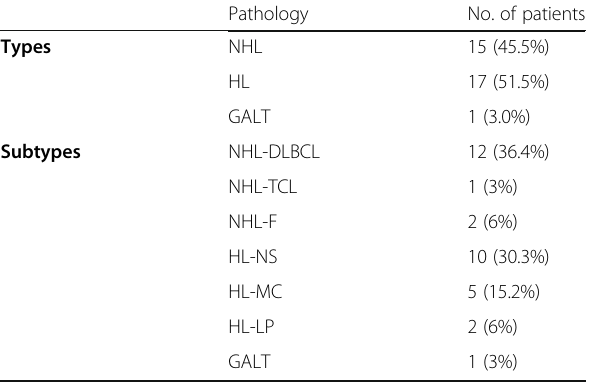
Table 2 Different pathological types and subtypes of the study population